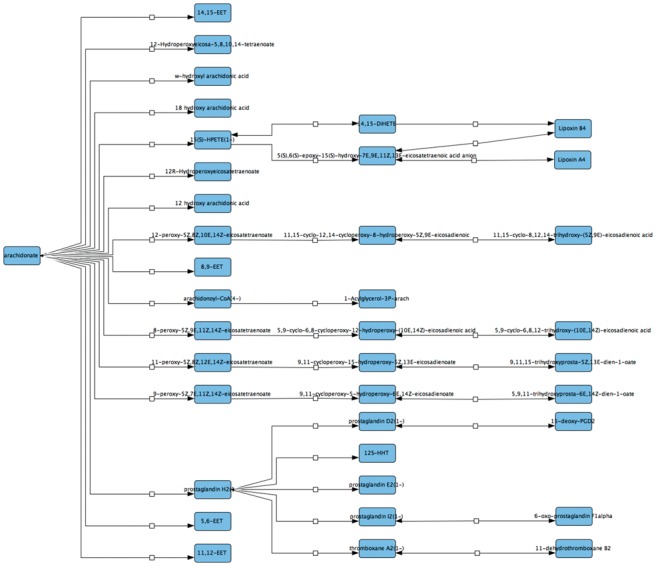
Visualization using CellDesigner (Funahashi et al., 2008) for the arachidonic acid metabolic network identified based on Cypher query 1 (Supplementary file S4)